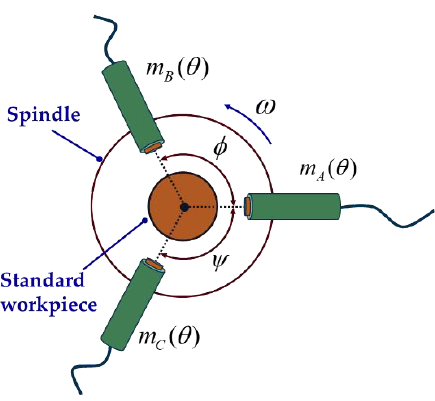
Figure 4. Schematic diagram of sensor distribution of three-point method.